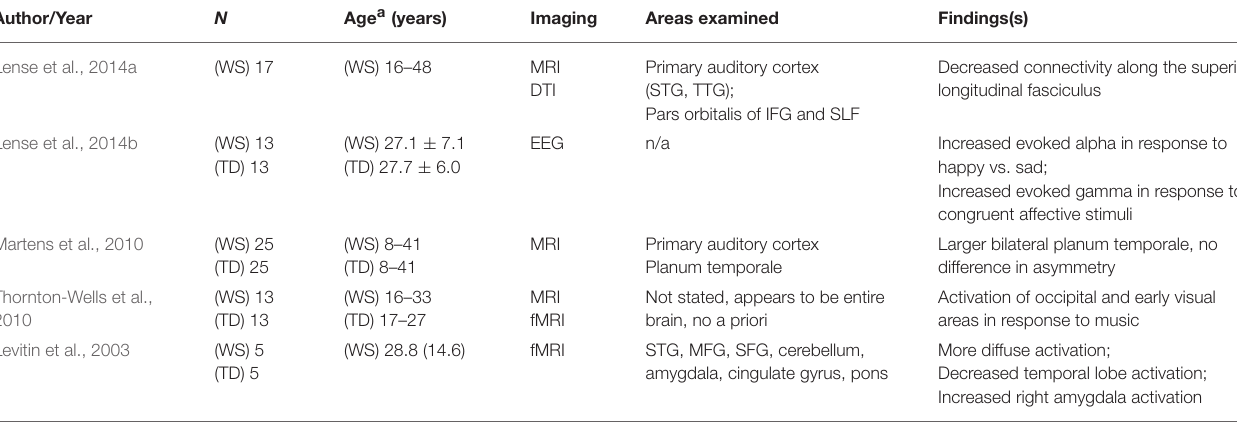
TABLE 6 | Brain imaging and